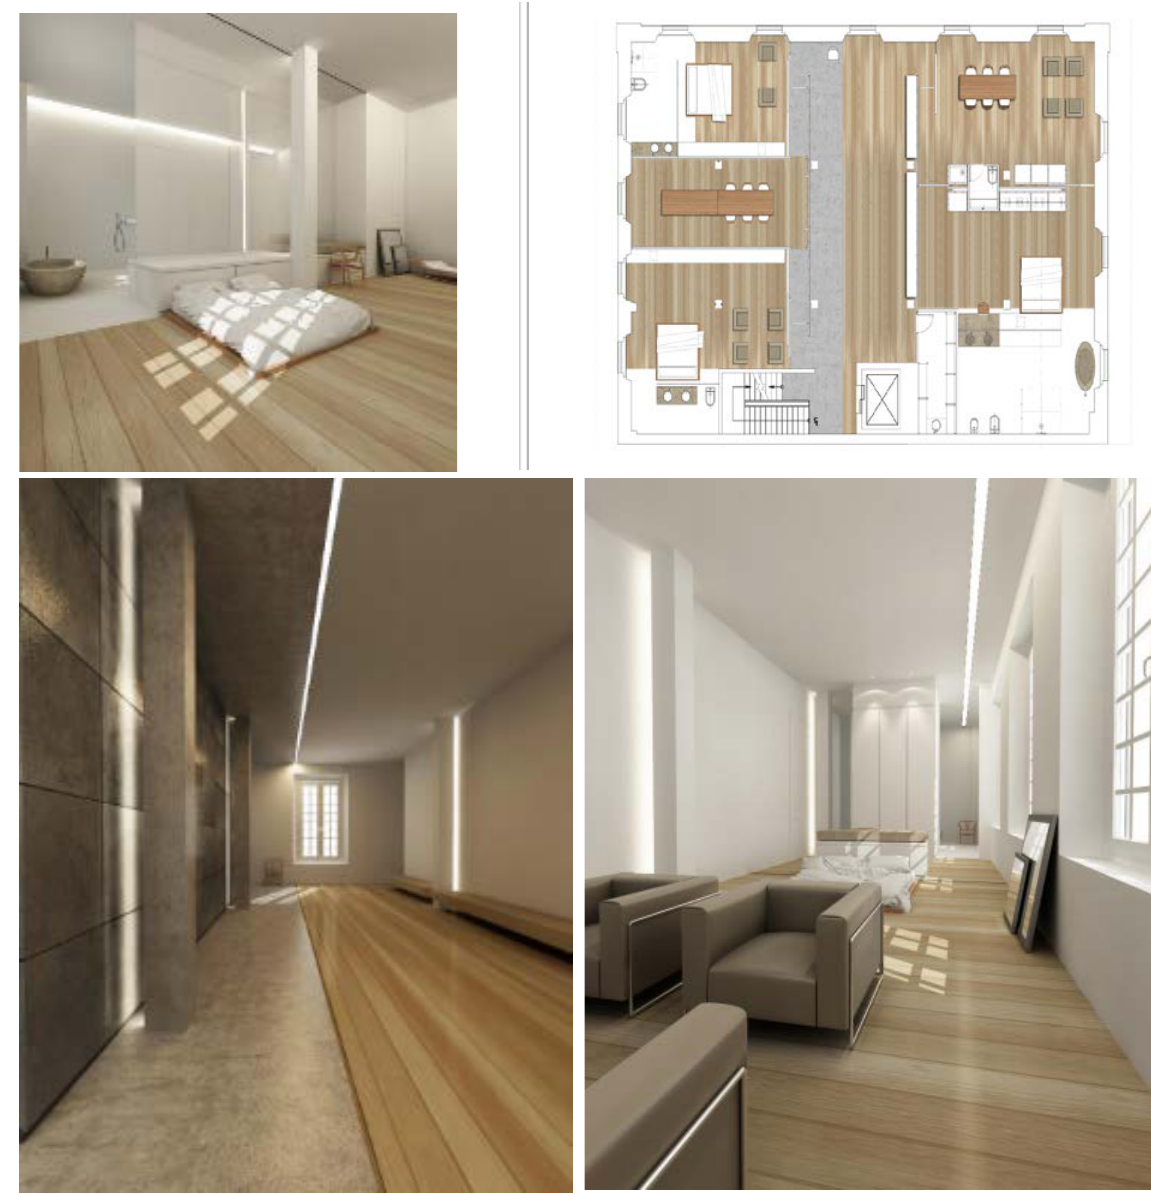
Figure6 Photo Credits to I.D. Joy